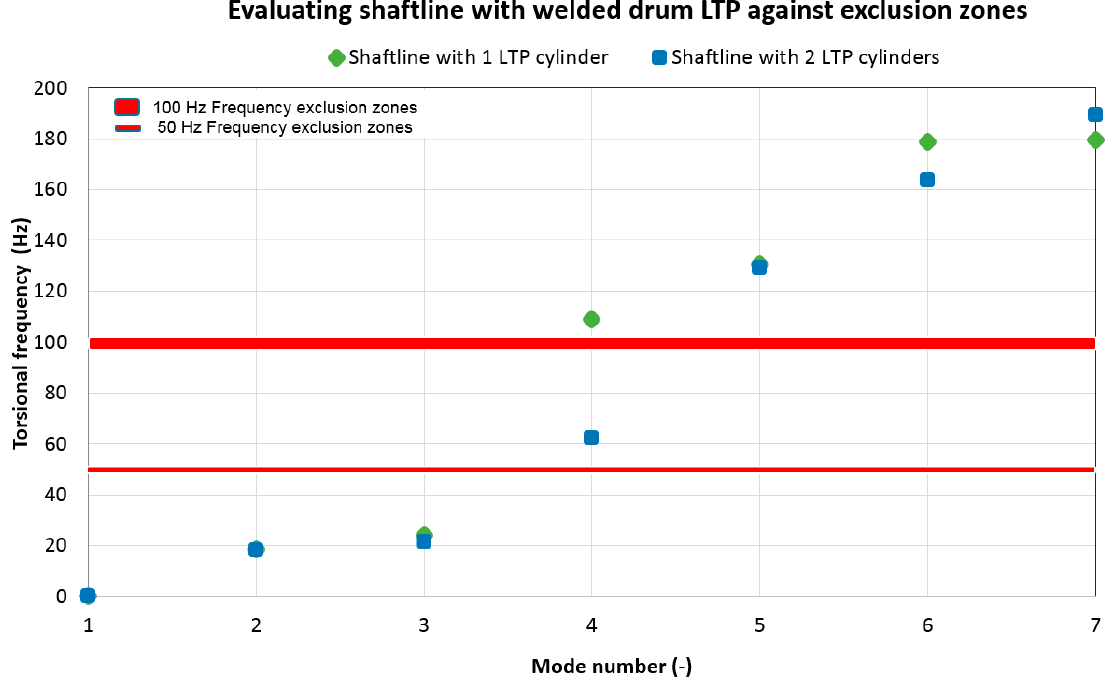
Figure 12. Evaluating welded drum LPT cylinder shaft frequency.